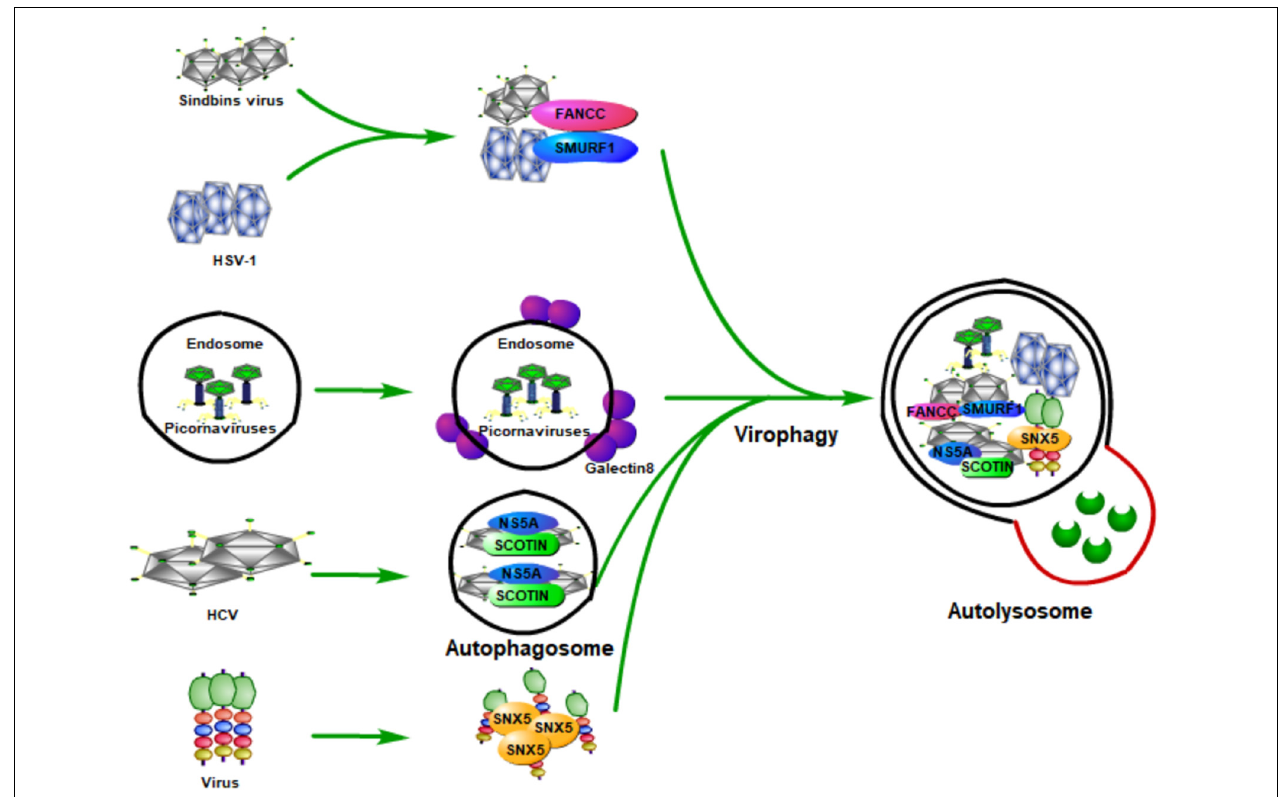
FIGURE 2 | Host autophagy fights viral infection by selectively targeting viral particles to lysosome for degradation. During the viral infection, host autophagy can be inducted (known as virophagy), which can degrade viral particles, viral components, as well as host factors that are required by viruses for their replication. Some viruses are degraded by selective autophagy by being recognized by specific proteins of the host. Smad-Ubiquitin Regulatory Factor 1 (SMURF1), a HECT-domain ubiquitin ligase, and Fanconi anemia group C protein (FANCC) can target Sindbis capsid protein as well as the herpes simplex virus type 1 (HSV-1) to autophagosomes for virophagy, contributing to prevent viral infection. The invasion of the picornaviruses will puncture the endosomal membrane to release their genome into the host cytoplasm, causing the exposure of β -galactosides. Galectin-8 could specifically recognize β -galactosides and therefore mark the permeated endosomes for autophagic degradation. The endoplasmic reticulum (ER) protein SCOTIN can inhibit HCV replication by interacting with the HCV non-structural 5A (NS5A) protein, a critical factor for HCV replication, which can help to form autophagosomes for degradation and suppress infectious virion production in